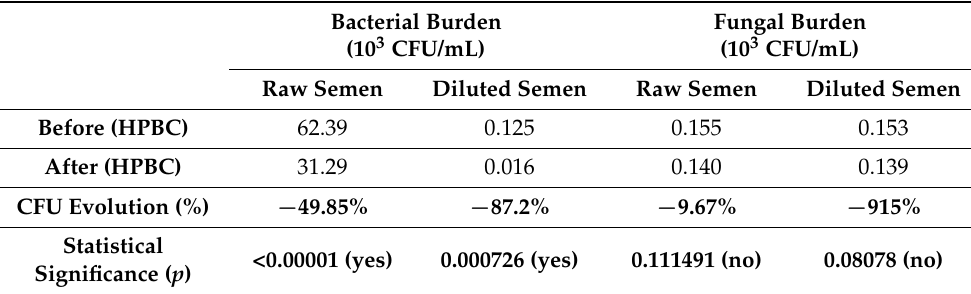
Table 4. Microbiological spermogram before and after the use of hygiene protocol and the biosecurity of sperm collection (HPBC).